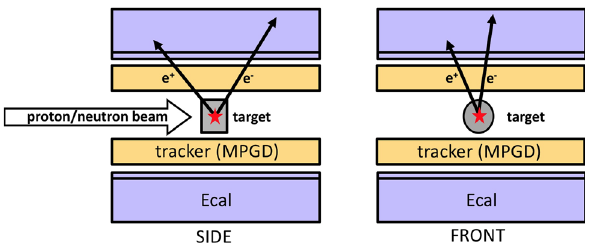
Fig. 18 Sketch of the experimental